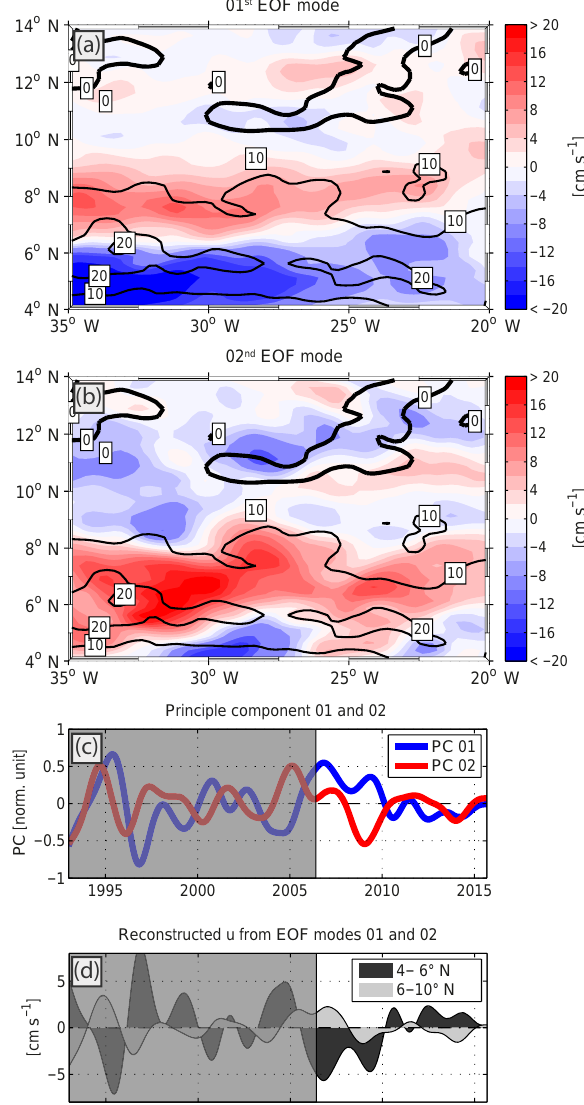
Figure 12. (a) First and (b) second EOF modes of the filtered (mean and seasonal cycle removed and subsequently 2-year low- pass filtered; see text for details) surface zonal geostrophic veloc- ity from Aviso (filled contours; positive eastward) for the tropical North Atlantic. Black contours define isolines of mean surface zonal geostrophic velocity from Aviso in cms − 1 (positive eastward). (c) Principle components 01 and 02 corresponding to the first two EOF modes given in (a) and (b) . (d) Time series of eastward velocity (averaged between 35 and 20 ◦ W for the latitude bands 4–6 and 6– 10 ◦ N) reconstructed from the first two EOF modes, given in (a) and (b) , and corresponding principle components in (c) . White boxes (right segments of panels c and d ) mark the time period (2006– 2015) of shipboard observations used for the estimate of the decadal oxygen and salinity trend section in Fig. 6 (cf. Table 1). Gray boxes (left segments) mark the time period